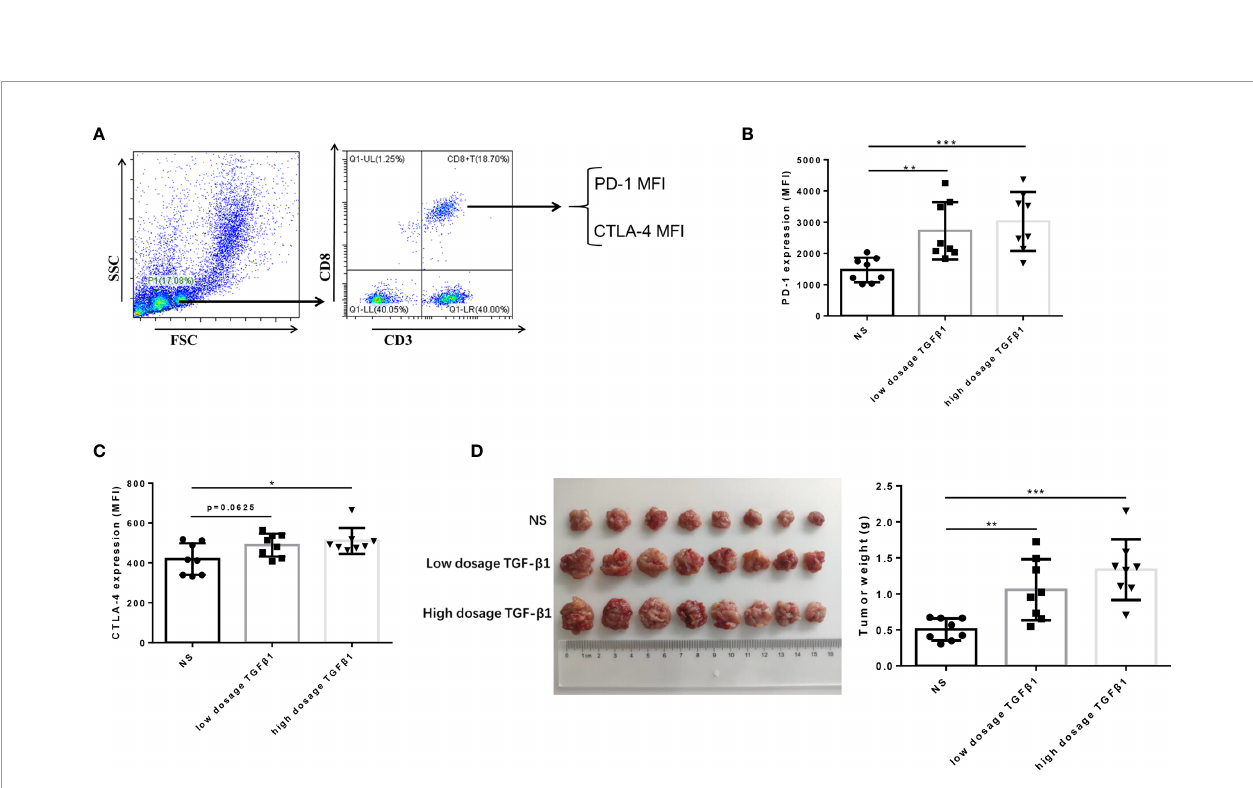
FIGURE 4 | TGF- b 1 upregulates the expression of PD-1 and CTLA-4 on CD8+ T cells and promotes HCC growth in vivo . (A) Flow cytometry was used to isolate CD3+ CD8+ T cells from peripheral blood mononuclear cells and detect the fl uorescence intensity of PE-conjugated PD-1 protein and FITC-conjugated CTLA-4 protein on the cell surface. (B) Flow cytometry was used to detect the expression of PD-1 on CD8+ T cells in the peripheral blood of mice with HCC. (C) Flow cytometry was used to detect the expression of CTLA-4 on CD8+ T cells in the peripheral blood of mice with HCC. (D) Subcutaneous tumors extracted from Kunming mice 14 days after implantation, and the weight of these tumors. n = 3, *P < 0.05, **P < 0.01, ***P < 0.001 vs. control